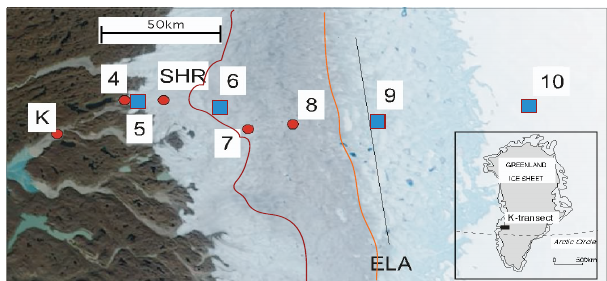
Figure 1. The K-transect in West Greenland. K is Kangerlussuaq. The sites 4, 5, SHR, 6, 7, 8, 9 and 10 are mass balance sites. The blue squares indicate the position of the IMAU weather stations. The equilibrium line altitude is located close to Site 9. The two coloured lines indicate the dark zone where albedo is lower than in the surrounding areas (Wientjes and Oerlemans, 2010; Wientjes et al., 2011). Background is a true colour composition of NASA Modis / Terra from 26 August 2003.